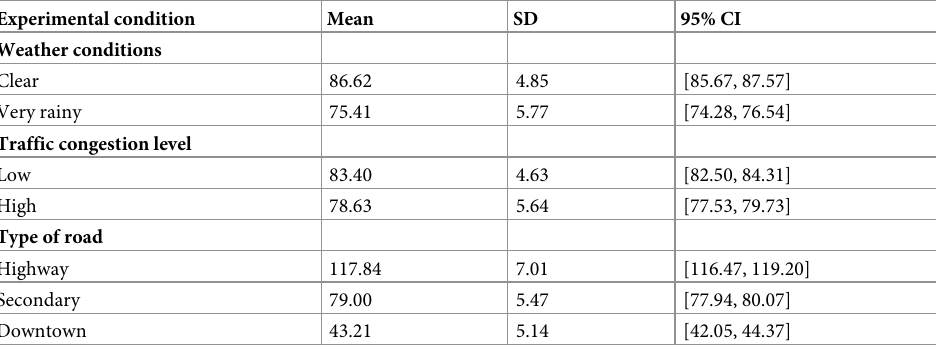
Table 3. Participants’ reported manual driving speed (in km/h) in the different experimental conditions. Experimental